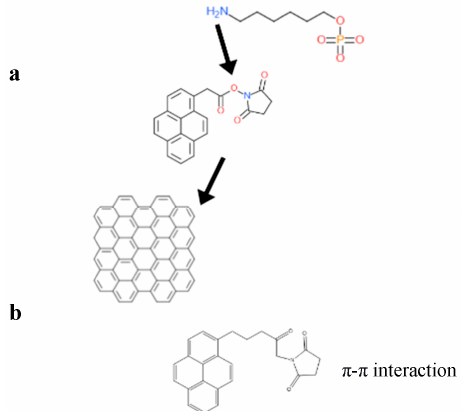
Figure 4. ( a ) The interaction of PBASE and graphene through its pyrene group moiety, while the N- hydroxysuccinimide ester group in PBASE reacts with NH2 group capped at the 5 ′ end of probe DNA. ( b ) The structure of a heterobifunctional linker, 1-pyrenebutyric acid N-hydroxy-succinimide (PBASE), composed of a pyrene moiety and a N-hydroxysuccinimide ester moiety.